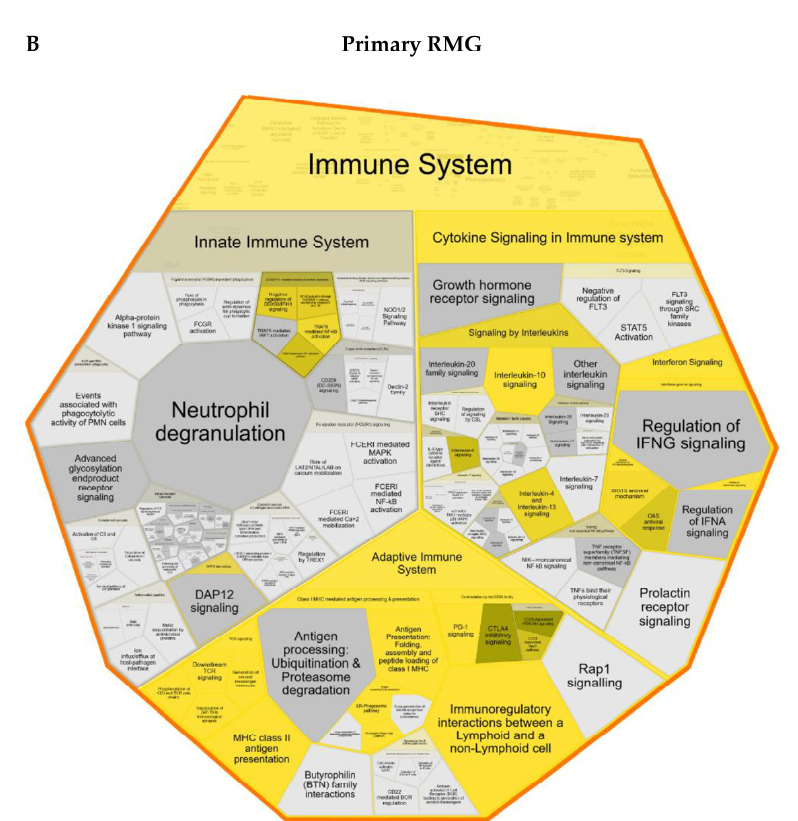
Figure 3. Voronoi diagram illustrating reactome analysis results comparing enriched pathways after LPS stimulation in ( A ) MIO-M1 cells and ( B ) primary retinal Müller glial cells (RMG). Enlarged polygon represents reactome superpathway immune system (for overview see Supplementary Figure S1 and Figure S2). Pathway enrichment analysis was calculated with human orthologue gene names of proteins with significantly higher abundance after LPS. Color intensity displays p -value of the statistical test for overrepresentation as illustrated by the color bar. Polygons colored in dark grey represent pathways without significant overrepresentation. Pathways without assigned proteins are displayed in light grey.